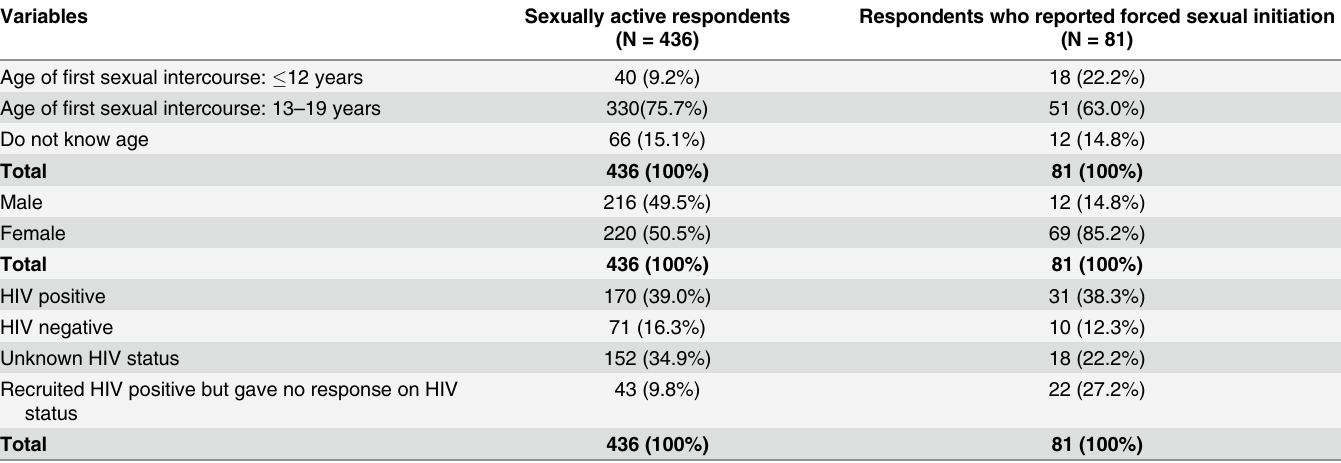
Table 1. Age and HIV status distribution of respondents by history of sexual intercourse.